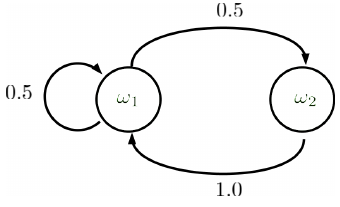
Figure 1. The transition probabilities defined by cooperative strategy profile η ∗ .